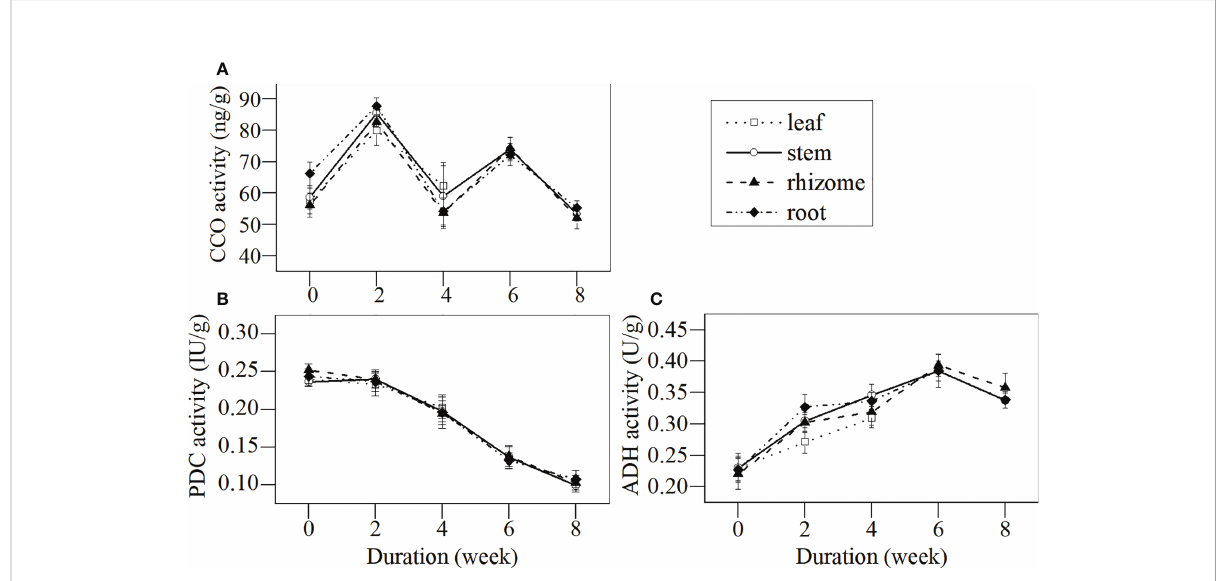
FIGURE 7 Dynamics of CCO, PDC, and ADH activities in different tissues of L. japonica during the senescence stage. Data are presented as mean ± SE. Each batch consisted of fi ve replicates, which had two repetitions in parallel. (A) CCO activity, (B) PDC activity, (C) ADH